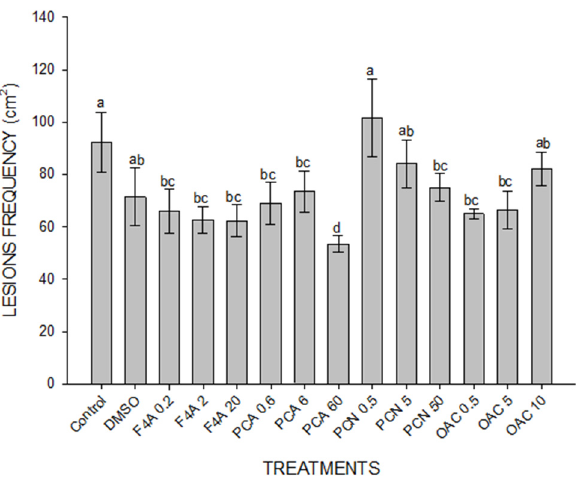
Figure 6. Frequency of lesions caused by P. pachyrhizi in soybean leaves treated with different secondary metabolites produced by P. aeruginosa LV strain, 14 days after inoculation. The fungal spores were inoculated 24 h after treatment. Distilled H 2 O (Control). Different letters indicate significant differences by Tukey test at p < 0.05. Bars indicate standard deviation. CV = 61.94%.